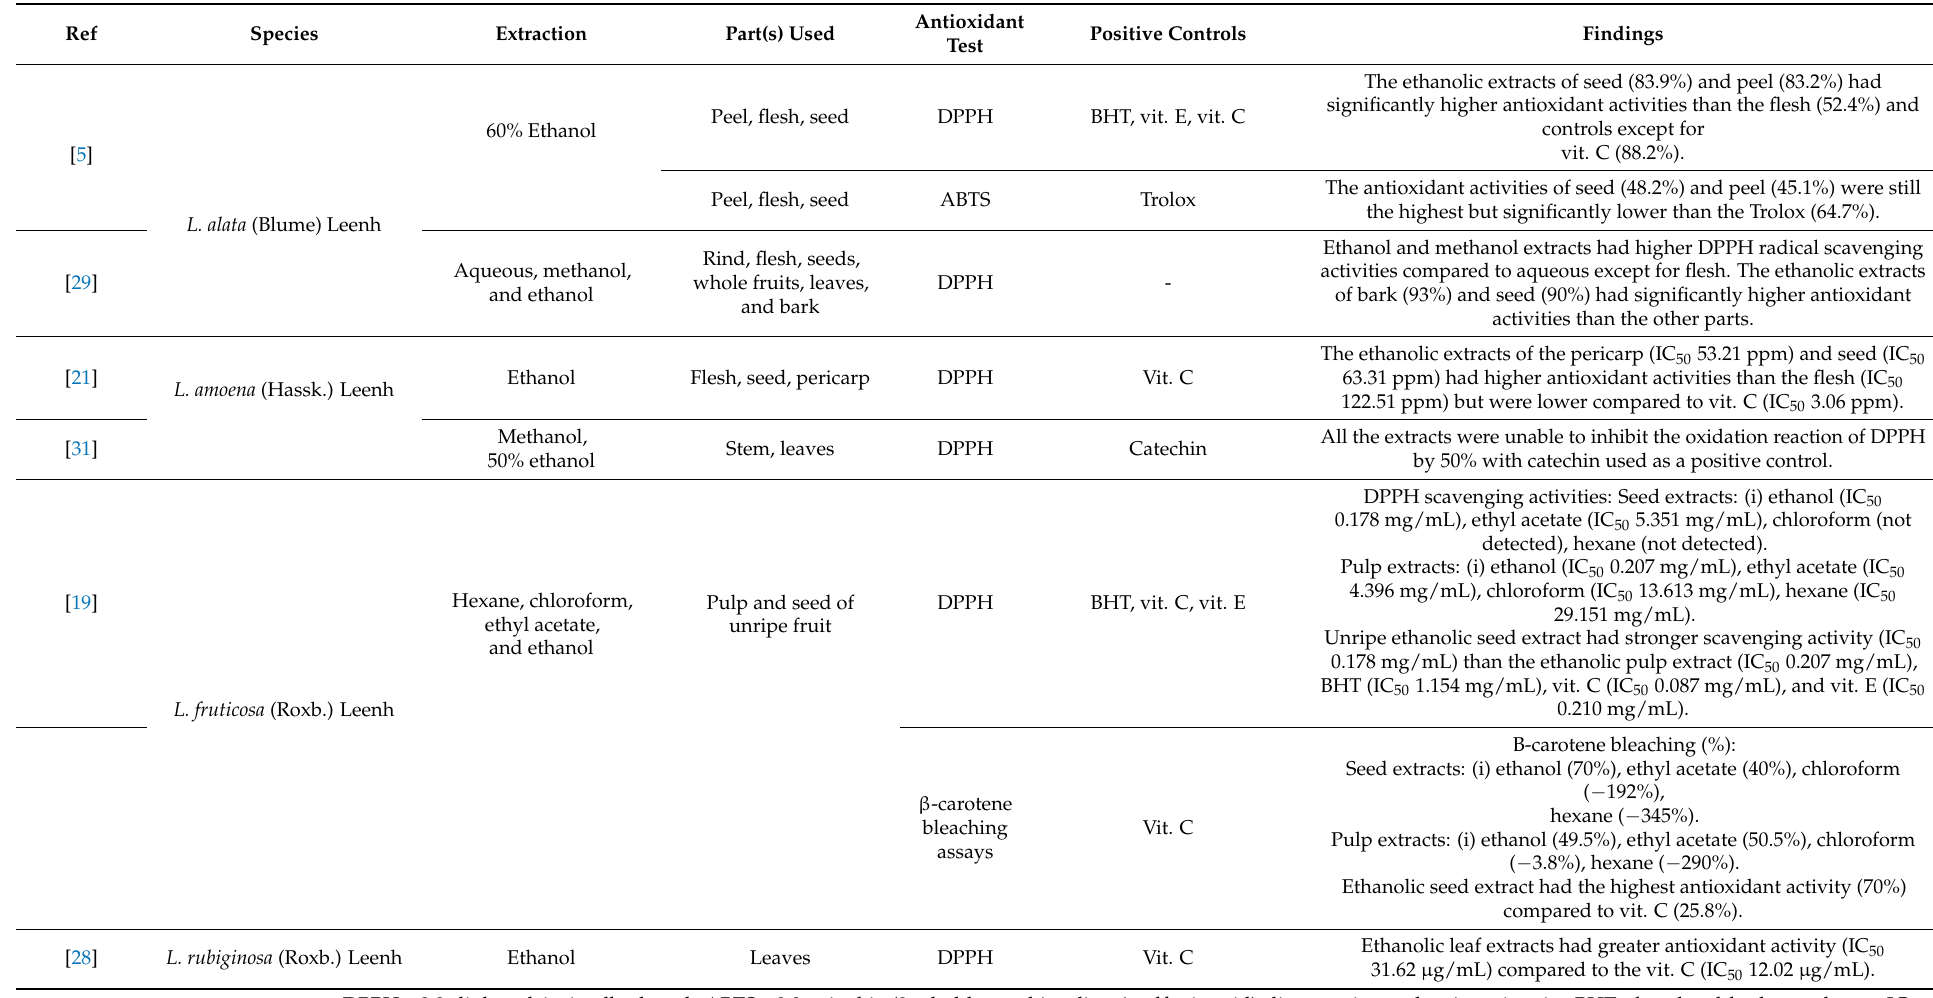
Table 4. Summary of the methods and antioxidant activities of Lepisanthes